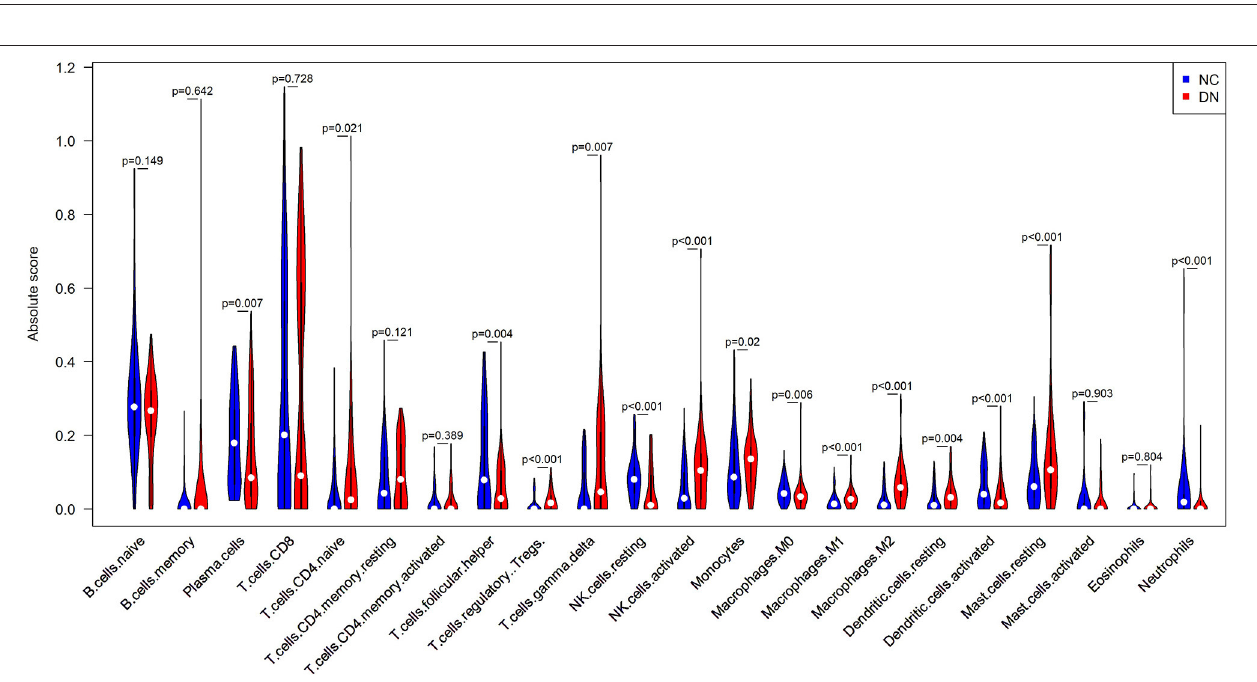
FIGURE 6 | Comparison of infiltrated immune cell subpopulations in glomerulus tissues with or without DN. Violin plot of immune-infiltrating lymphocytes between DN glomerular tissues and healthy control glomerular samples, in which the red represents DN samples, and the blue represents control samples.